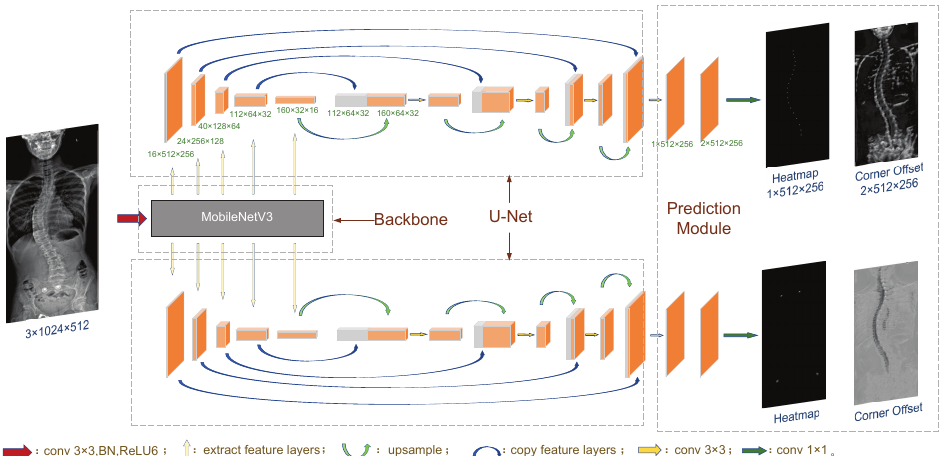
Figure 2. The network structure for vertebral key points